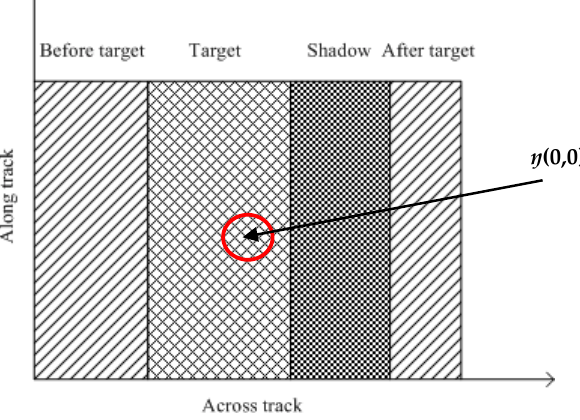
Figure 5. Schematic diagram of the matching model.